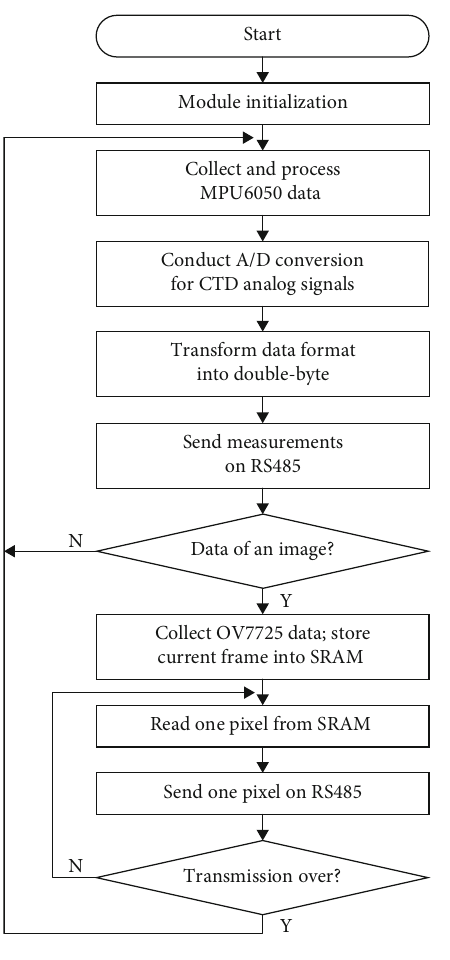
Figure 6: Flow chart of the slave computer.